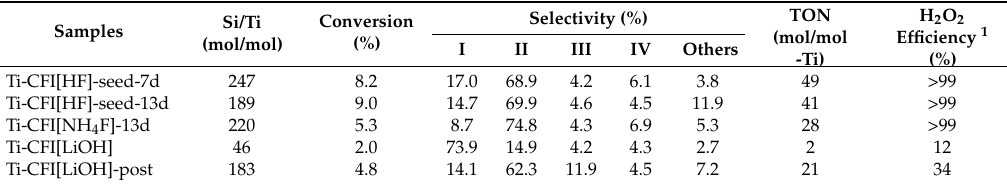
Table 2. Catalytic oxidation of cyclohexene over various Ti-CFI zeolites using H 2 O 2 aqueous solution as an oxidant.